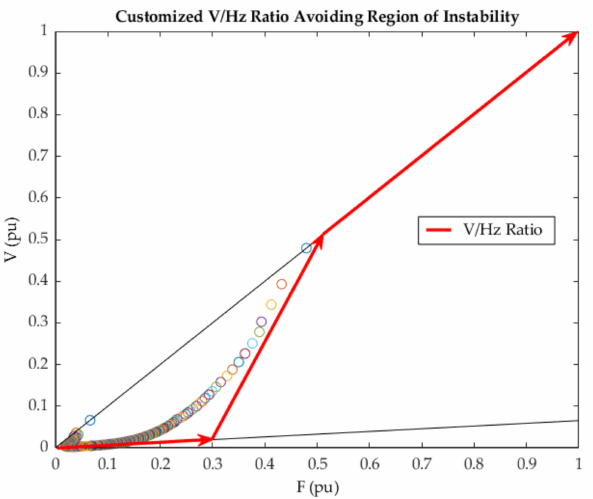
Figure 8. Customized V/Hz ratio to mitigate oscillations avoiding unstable operating points.